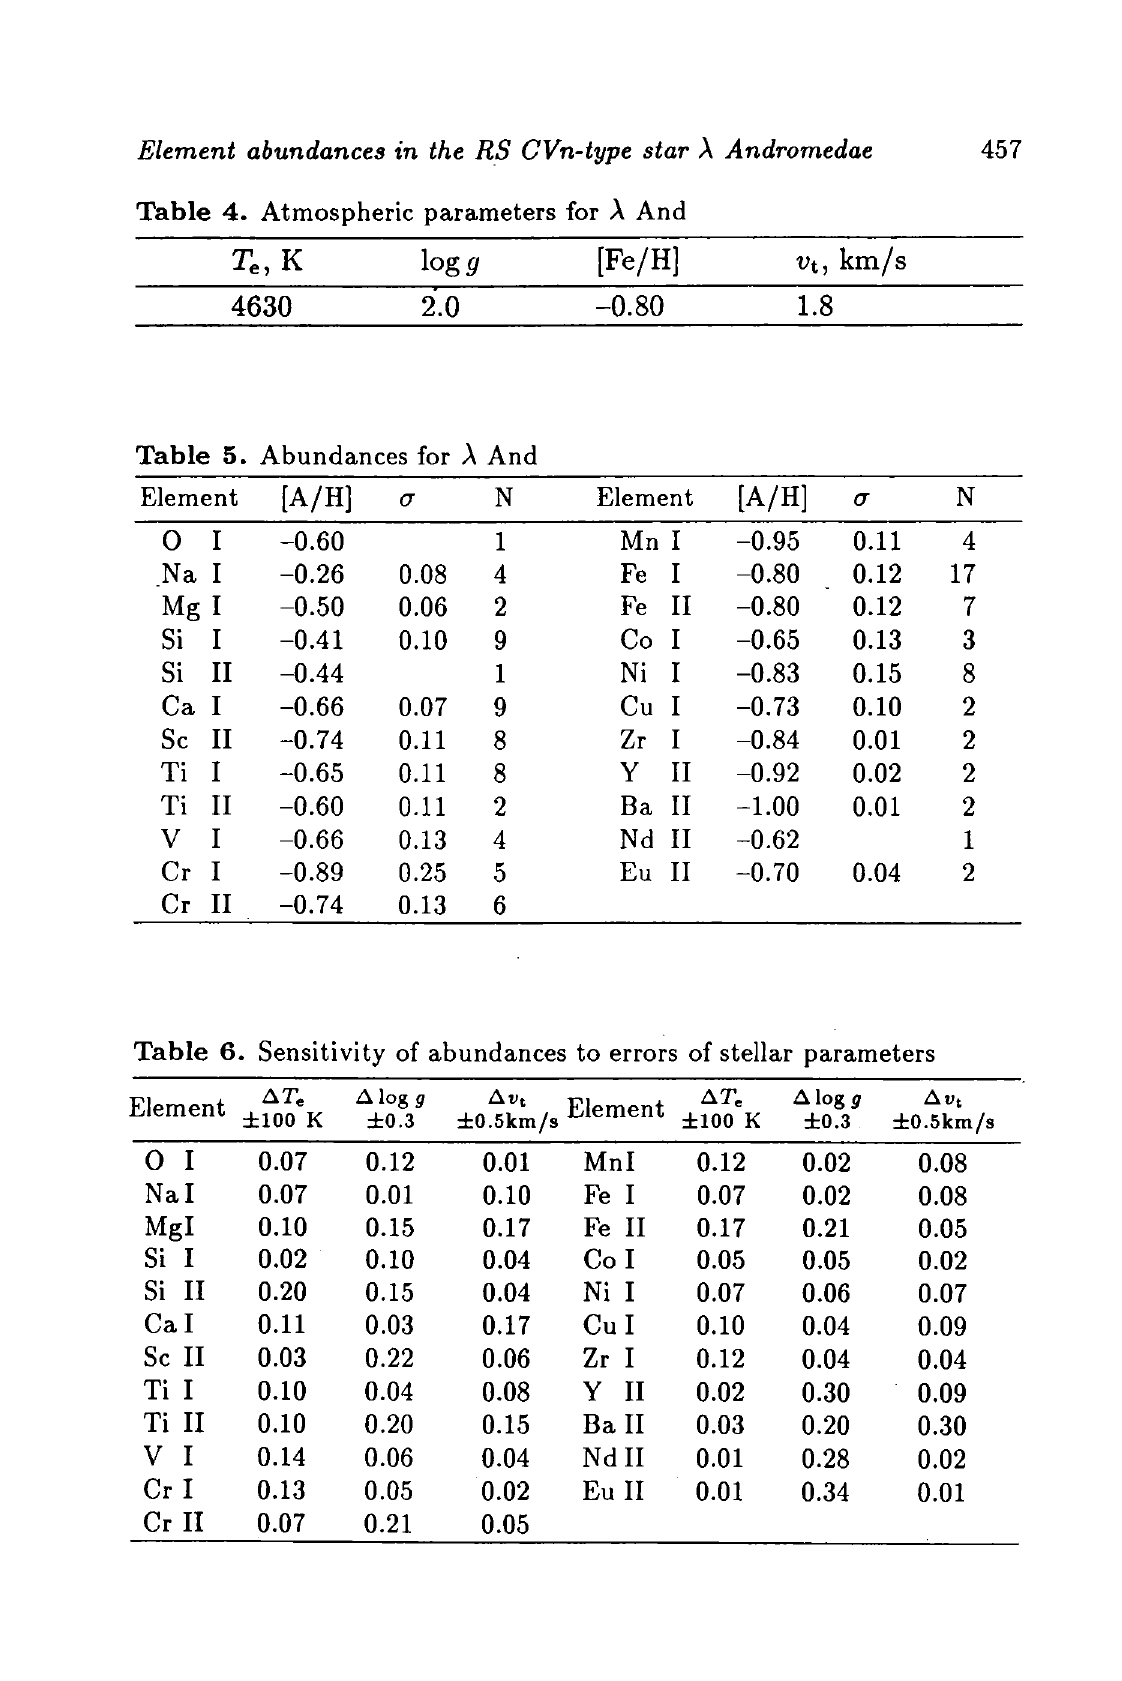
Table 4. Atmospheric parameters for A And